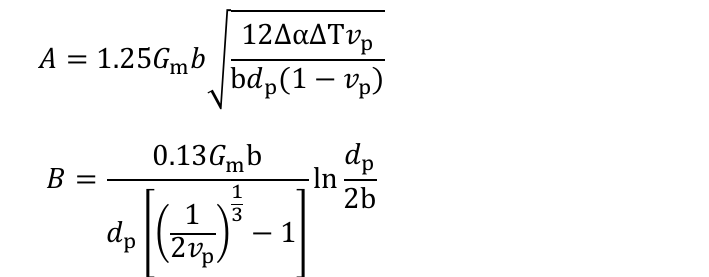
Figure 1. Effect of strengthening contributions and total resulting strengthening increment calculated by Equation (10) for a 2 wt.% Al